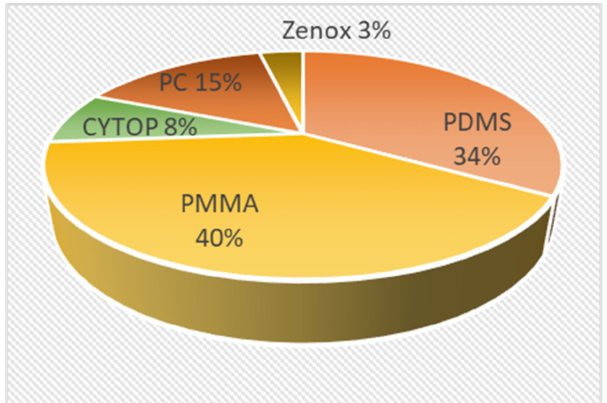
Figure 1. The percentage of a given polymer in the total number of articles on POF published in